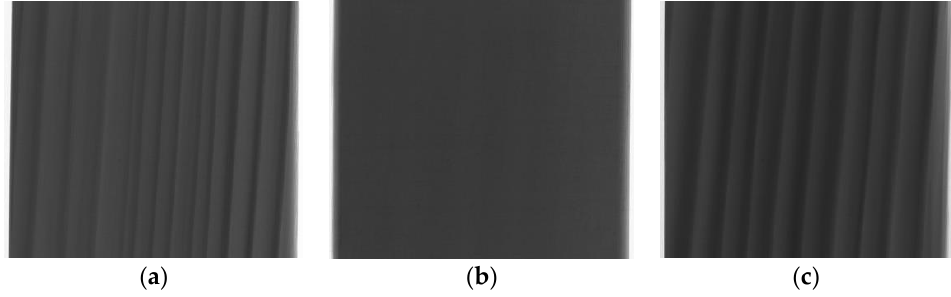
Figure 12. Exemplary projections for samples: ( a ) “1”; ( b ) “2”; ( c ) “3” (scale 200%).